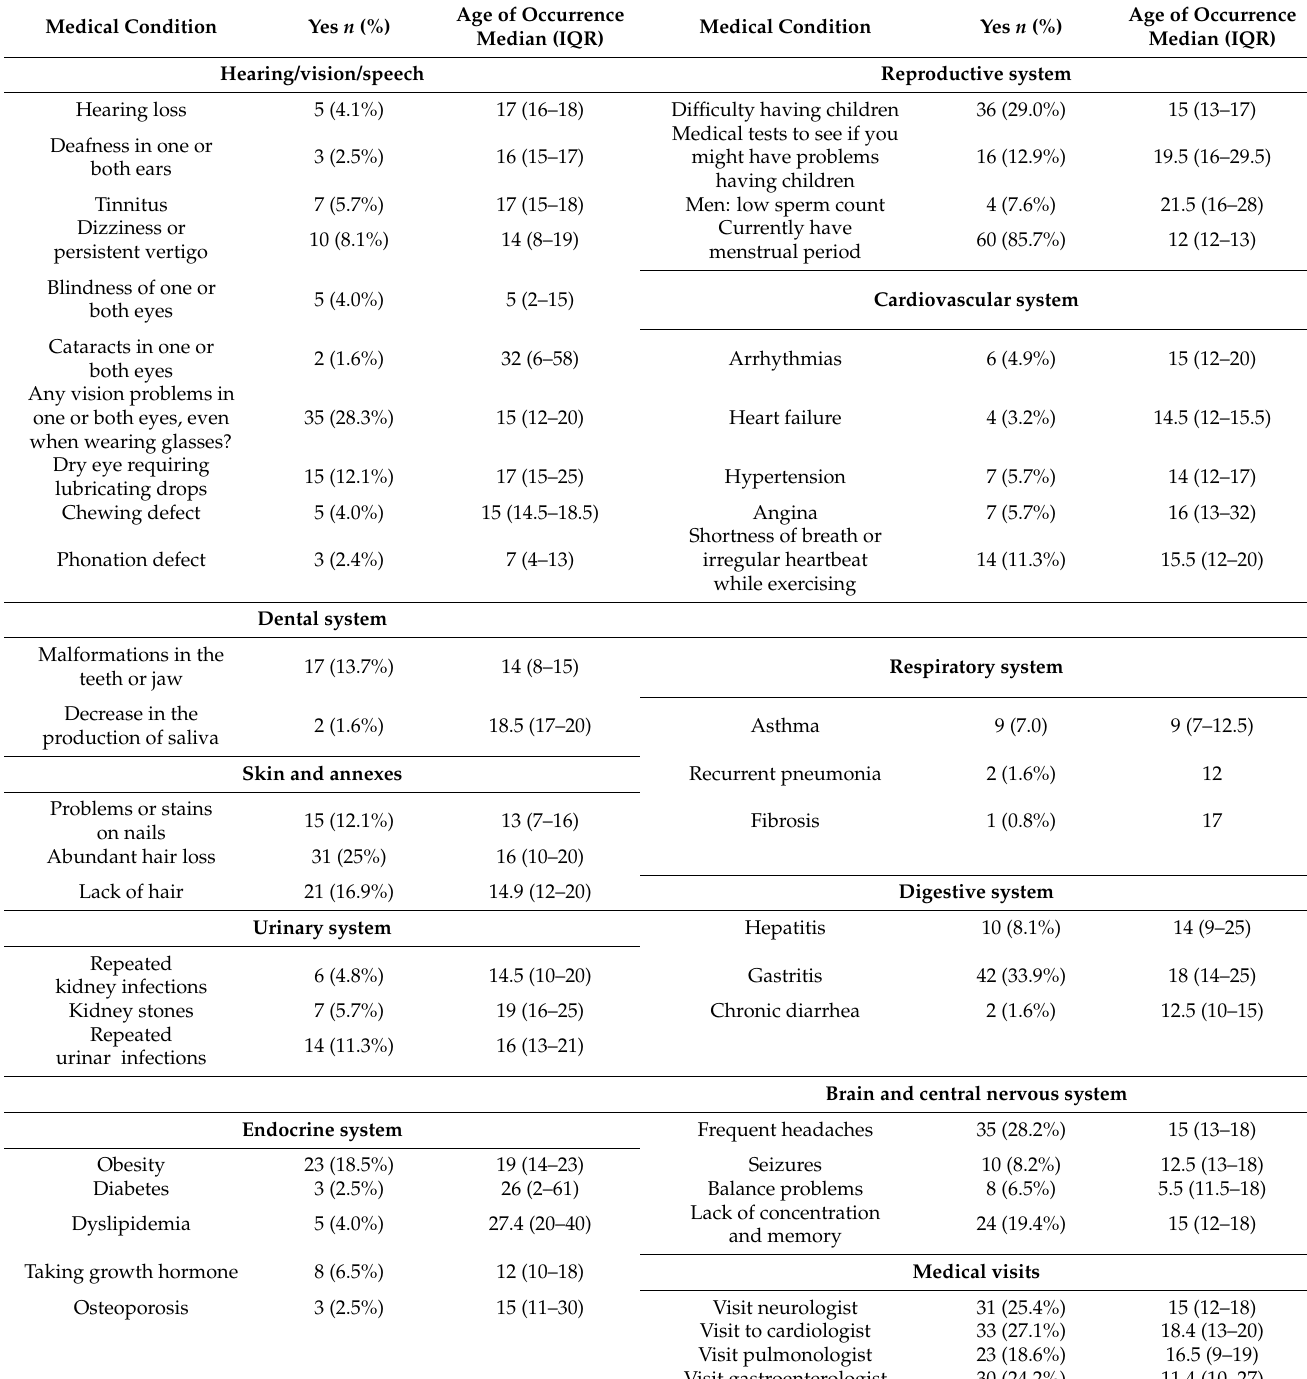
Table 3. Major self-reported health problems by Colombian